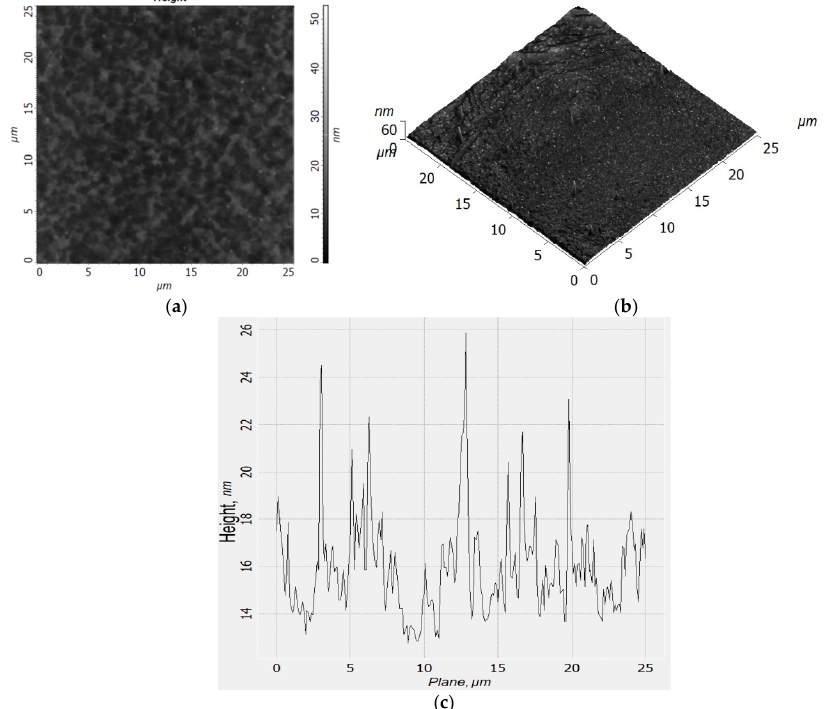
Figure 8. AFM images of the surface relief of spherical titanium hydride, modified with titanium salts in the presence of NH 4 OH: ( a ) 2D topographic image, ( b ) 3D topographic image, and ( c ) Surface profile.